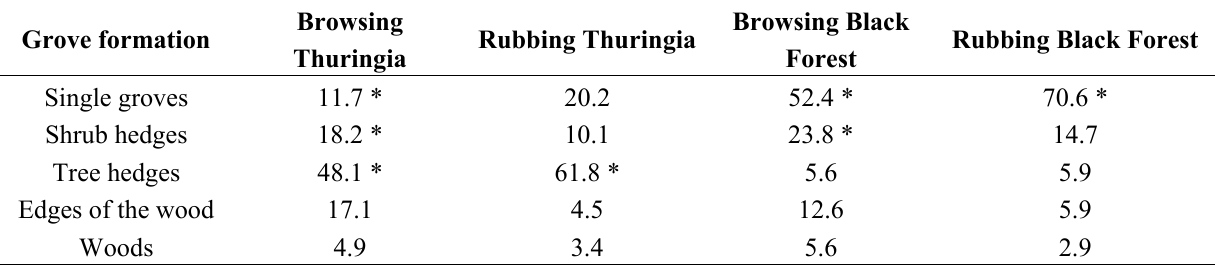
( n = 648) and Black Forest ( n = 143). *